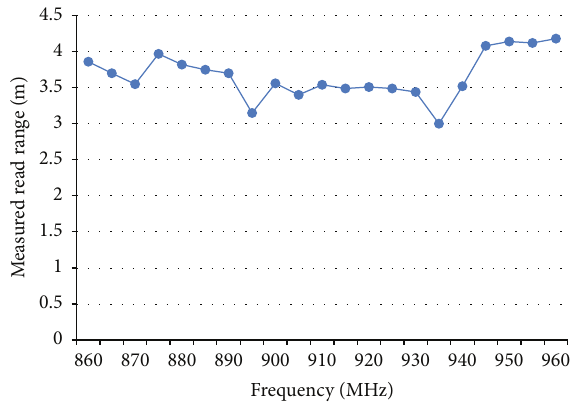
Figure 10: Measured read range of the proposed tag